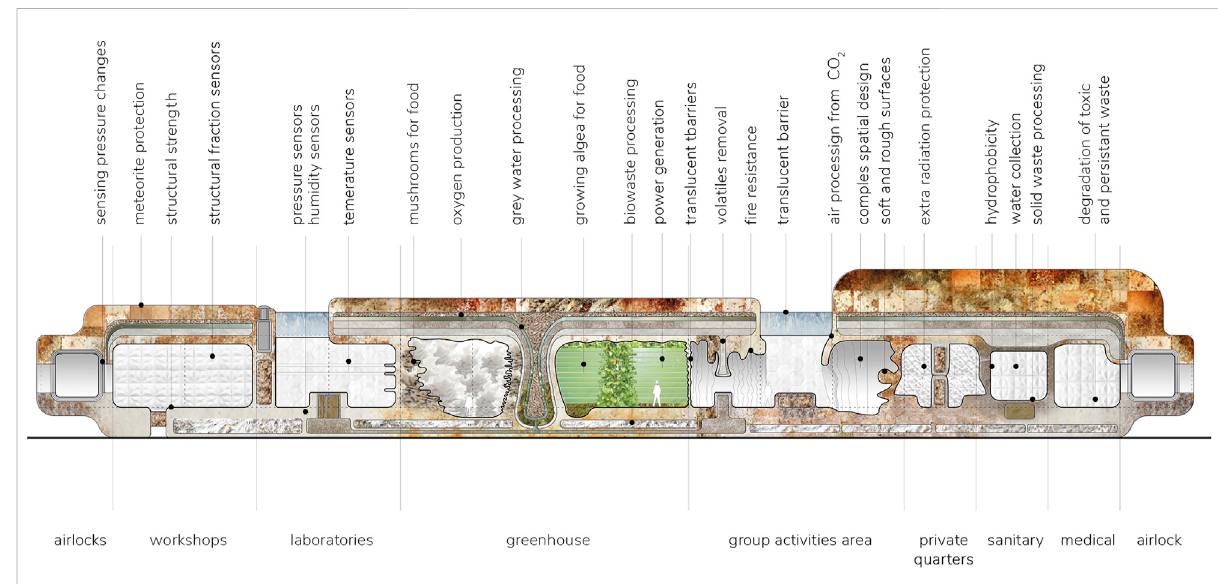
FIGURE 11 Variegated material properties and different functions of mycelium biocomposite in a space